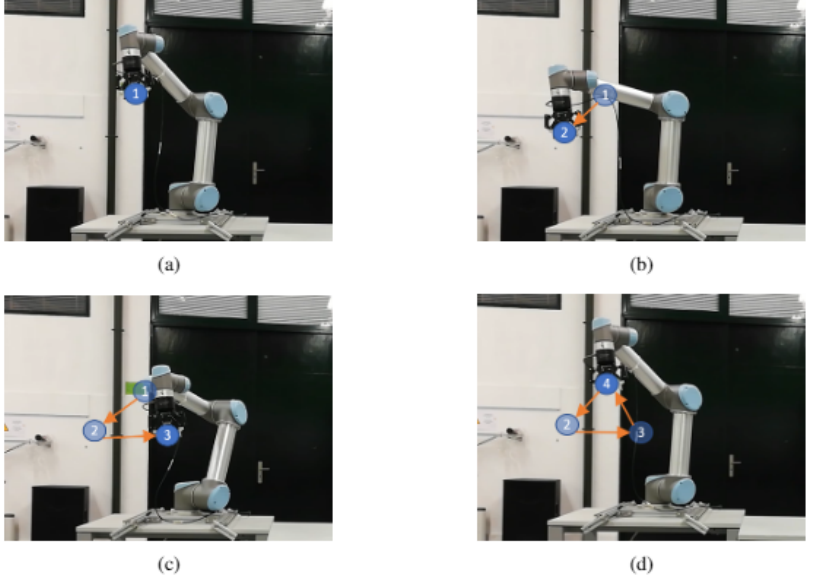
Figure 6. UR5 path execution (triangle): ( a ) Robot at initial point. ( b ) Robot at second point. ( c ) Robot at third point. ( d ) Robot at final point.